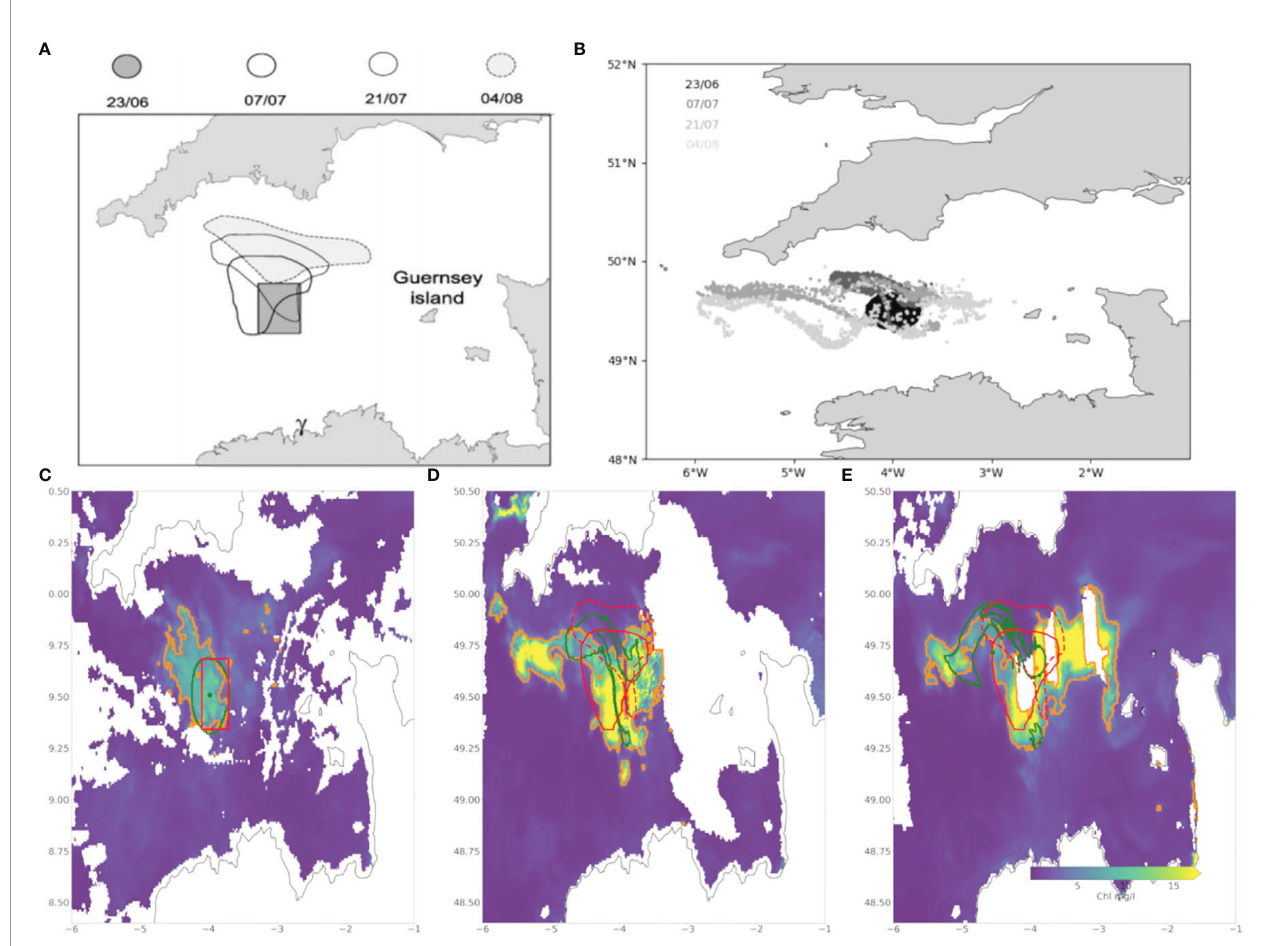
FIGURE 4 | Advection of passive tracer in the 2003 K . mikimotoi bloom (A) represented with isolines of modelled tracer concentration plotted every two weeks (reproduced from (Vanhoutte-Brunier et al. (2008)). The MARS3D model con fi guration had a 4x4 km resolution and 12 sigma levels from the south of Brittany (47.5N, 5.6W) to north of the Rhine river plume (52.5N, 5.0W). Lagrangian advection from the same period B ) observed with a con fi guration using a larger geographical domain and a higher vertical resolution (30 sigma layers). CCI remote sensing chlorophyll from the same period, showing three days when cloud cover was least ( C - 2003/06/23, D - 2003/07/09, E - 2003/07/13). The positive area for the particle run is shown in green, tracer from (Vanhoutte-Brunier et al. (2008) are shown in red for 07/07 (solid) and 21/07